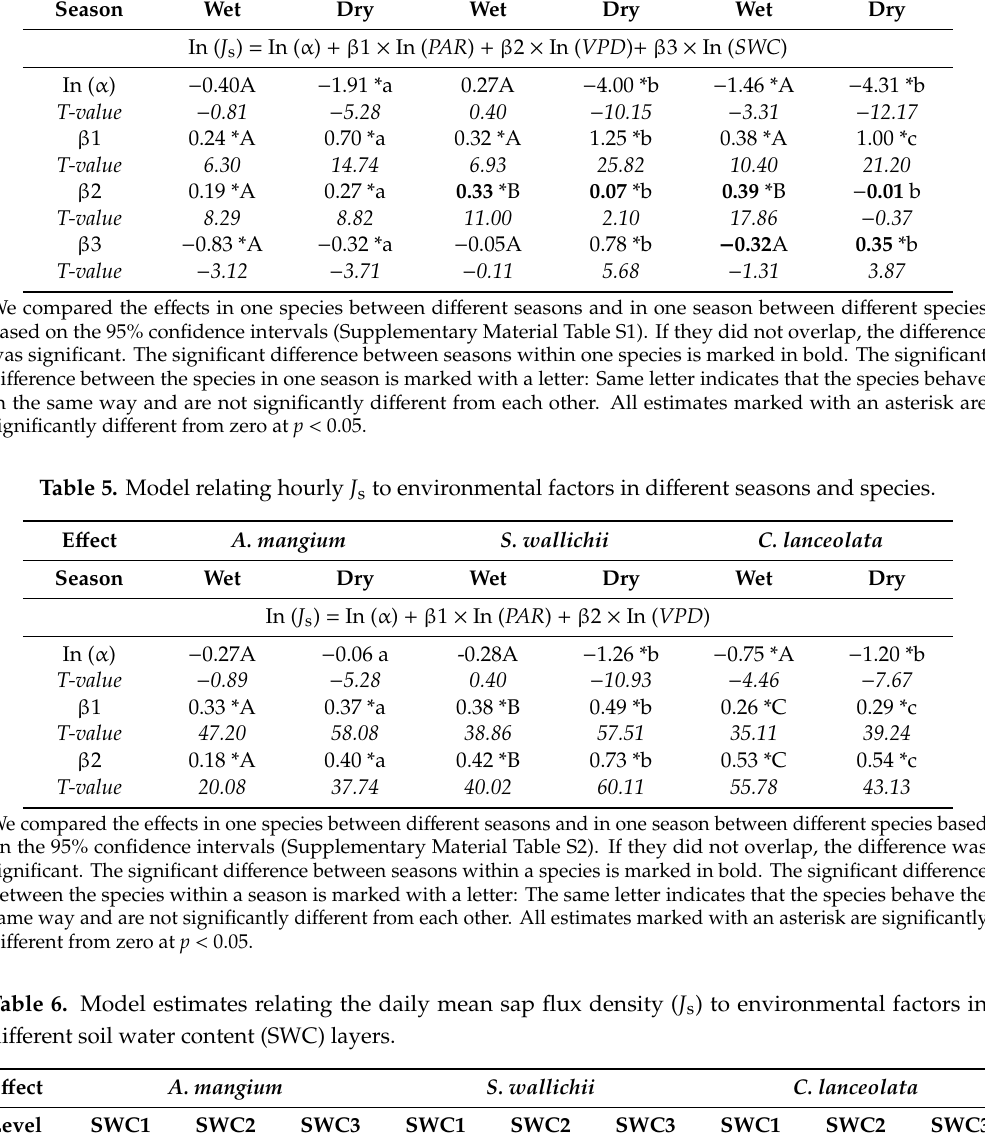
Table 4. Model relating daily J s to environmental factors in di ff erent seasons and species. E ff ect